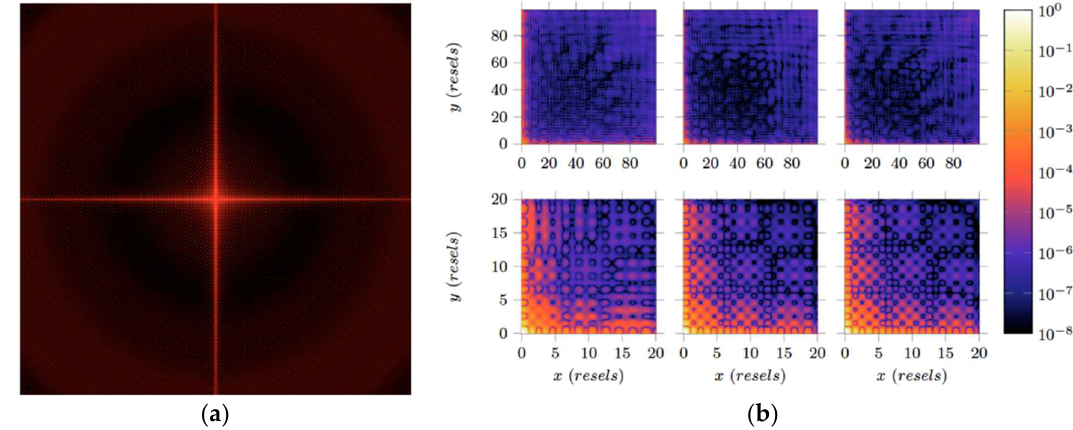
Figure 6. ( a ) Typical PSF at order 1 of a binary Fresnel zone plate for a square aperture; ( b ) Upper right quadrant of the PSFs of FIAs for various configurations (see [16] for details).